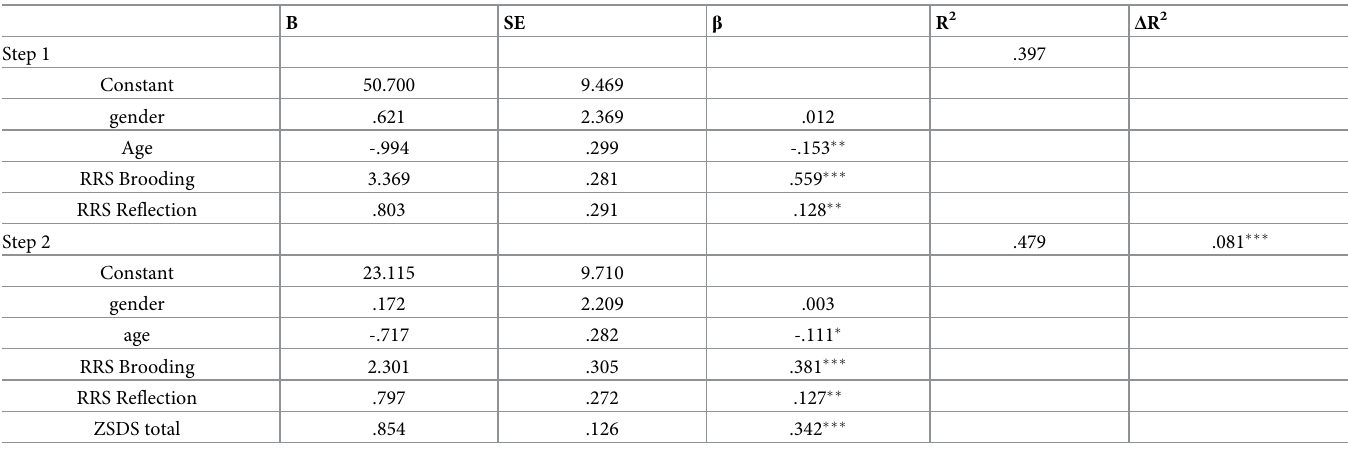
Table 9. Association between RTSQ total scores, trait rumination (measured by RRS) and depressed mood (ZSDS scores) after controlling for gender and age. B SE β R